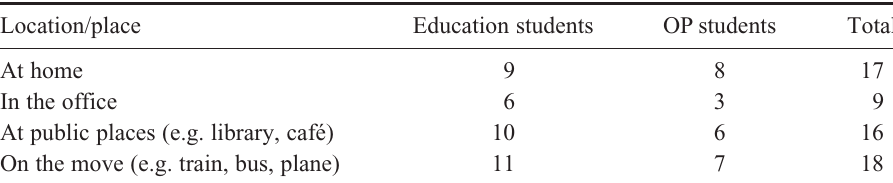
On the move (e.g. train, bus,